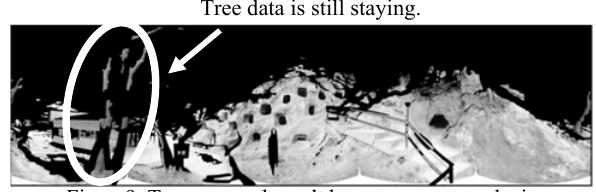
Figure9. Tree removal result by component analysis